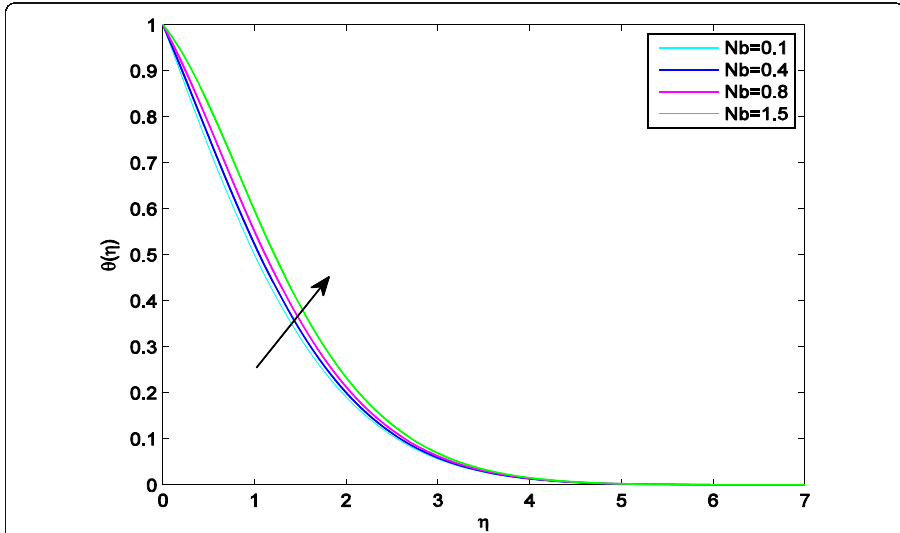
Fig. 12. Temperature graph for various values of